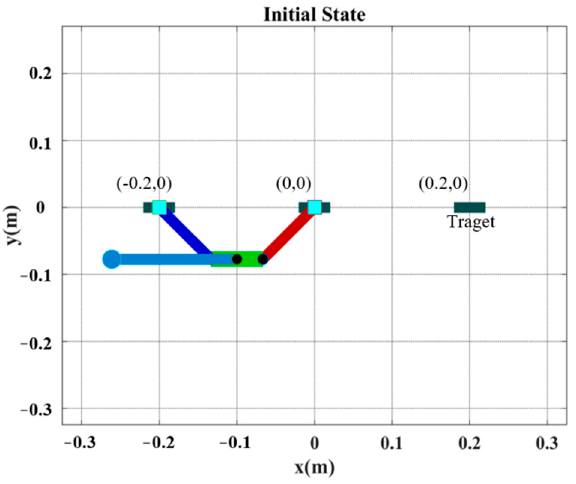
Figure 13. Simulation of ledge brachiation robot: initial posture.